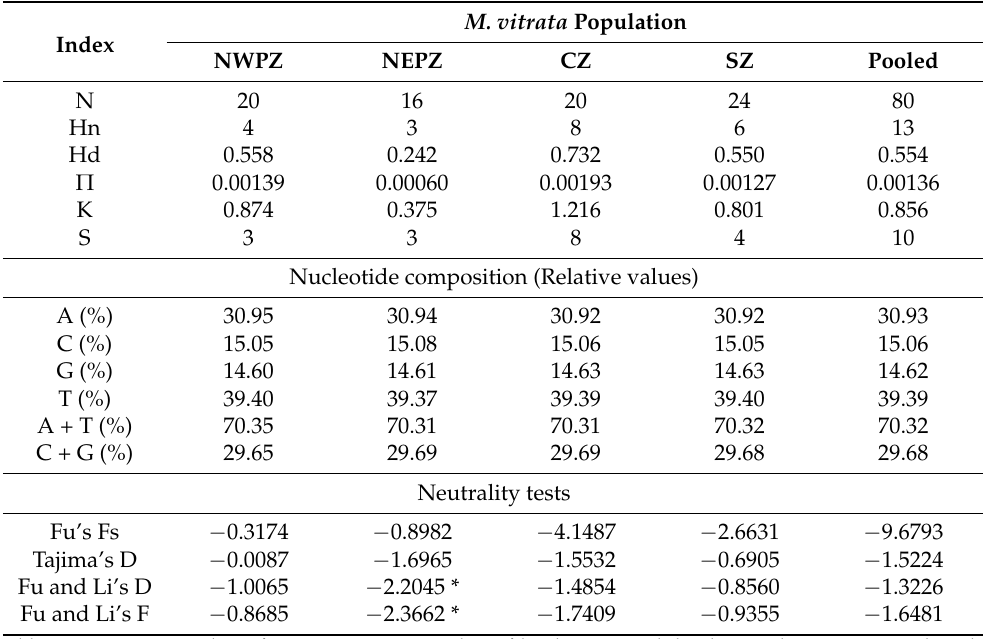
Table 2. Molecular diversity indices and neutrality test values based on COI gene sequences from different M. vitrata populations.